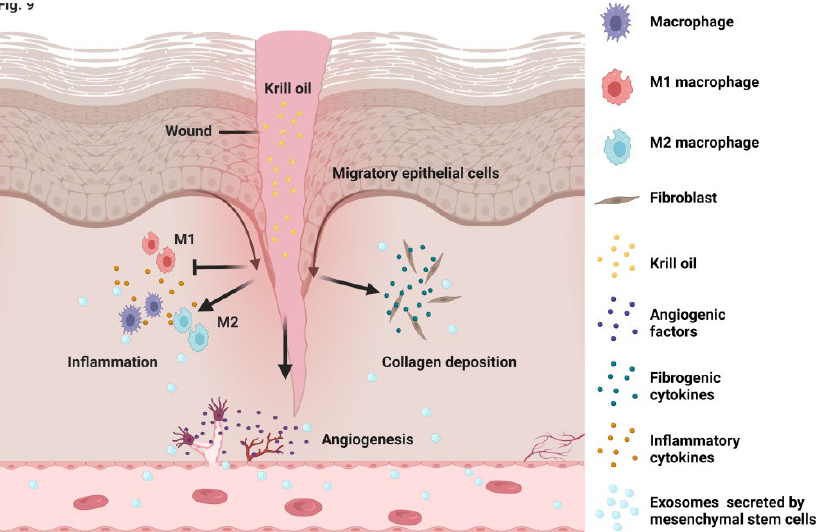
Figure 9. Schematic diagram for the actions of KO on diabetic wound healing. Macrophage, fibroblasts, and endothelial cells participate in the effect of KO on diabetic wound healing. Specifically, KO induced the M1 to M2 polarization of macrophages, increased the migration and collagen production of fibroblasts, and enhanced the neovascularization of endothelial cells.